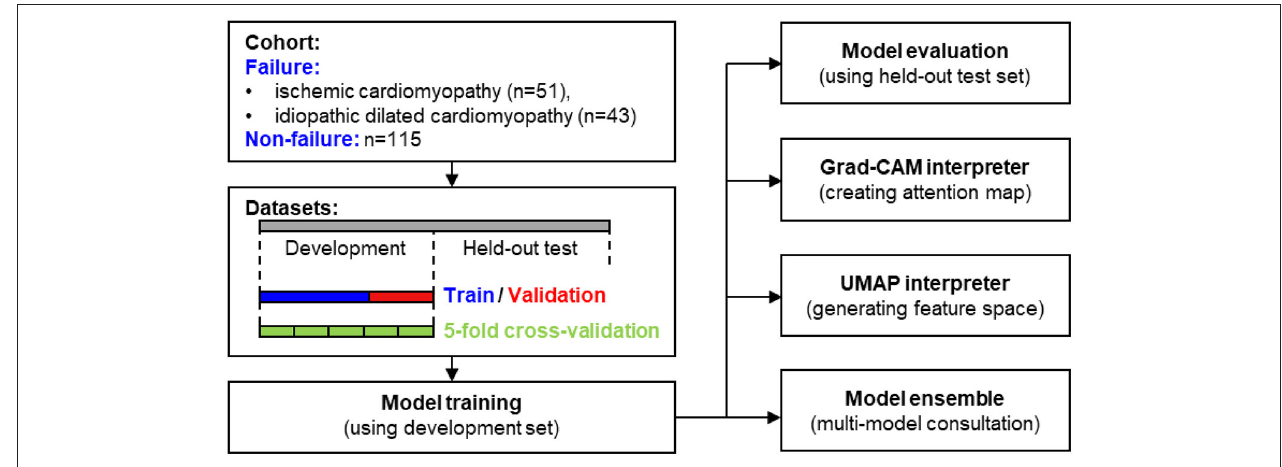
FIGURE 2 | The flowchart of the